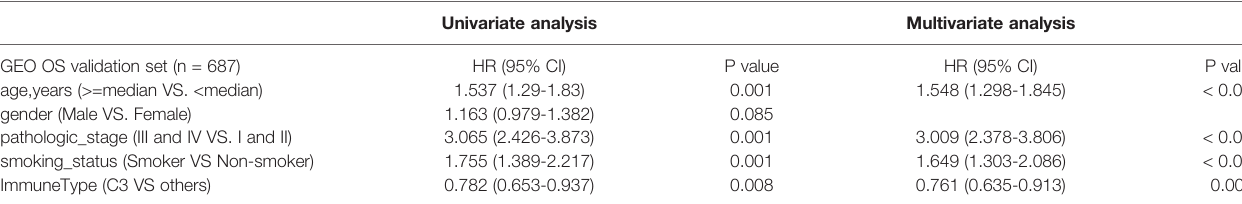
TABLE 2 | Univariate and multivariate Cox analyses of risk factors for survival prediction in 4 GEO LUAD cohorts. Univariate analysis Multivariate